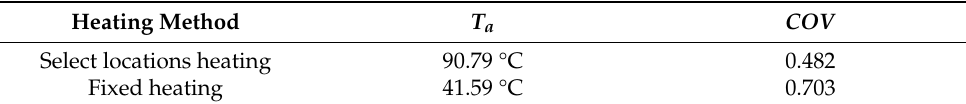
Table 8. Ta and COV after heating at select locations (material: distilled water).